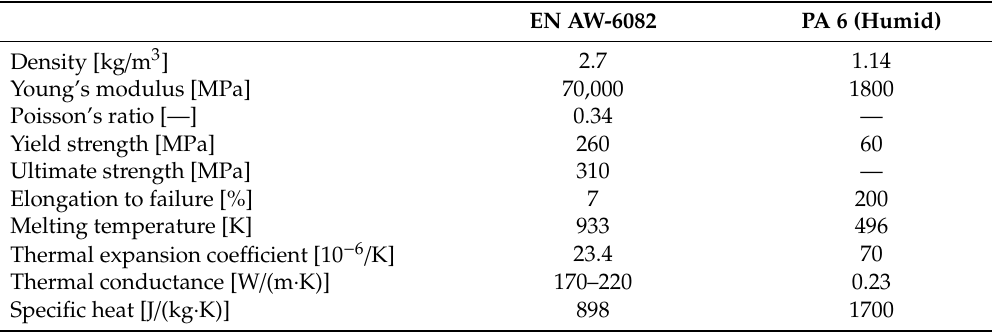
Table 1. Material properties of the used metal and